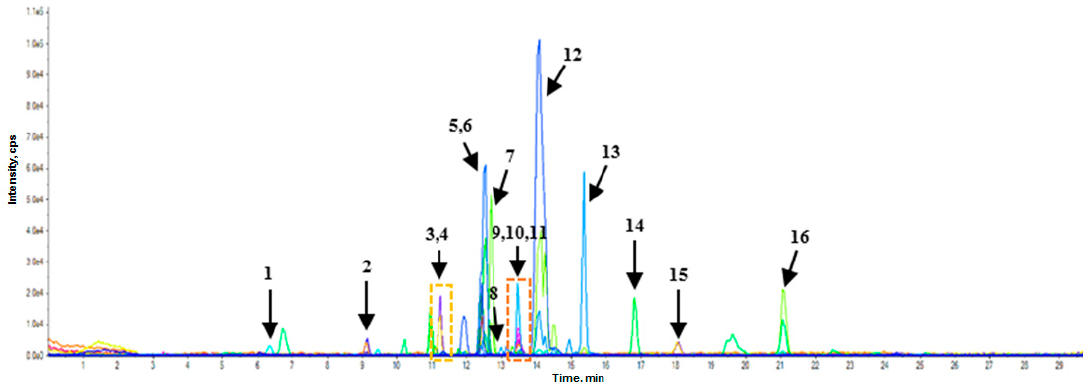
Figure 1. Multiple reactive monitoring (MRM) ion chromatogram of control raw soybean flour